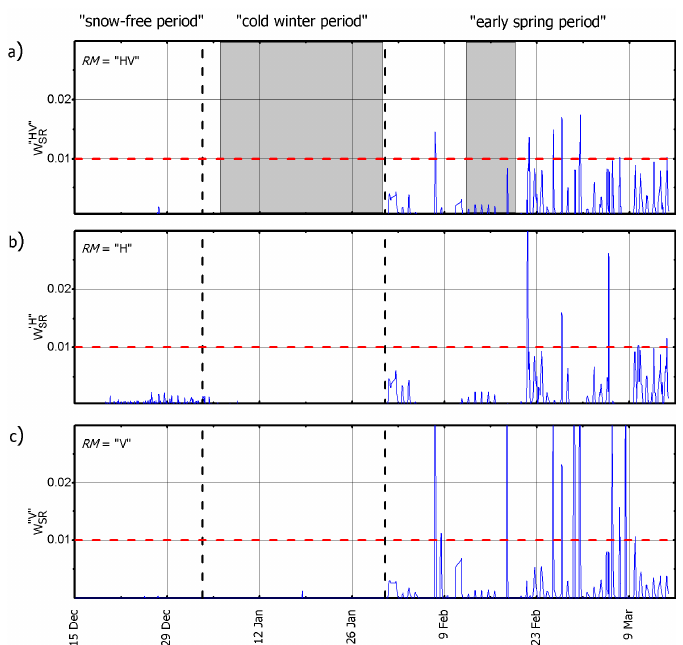
Figure 4. Retrievals (cid:1849) (cid:2903),(cid:2902)(cid:3019)(cid:3014) of snow liquid water content derived from (cid:1846) (cid:2886),(cid:2902)(cid:3043) ((cid:2016) (cid:3038) ) for ( a ) RM = “HV”, ( b ) RM = “H”, and ( c ) RM = “V”, respectively. Light gray overlays indicate the zoomed-in view of W RM shown in Figure S,R